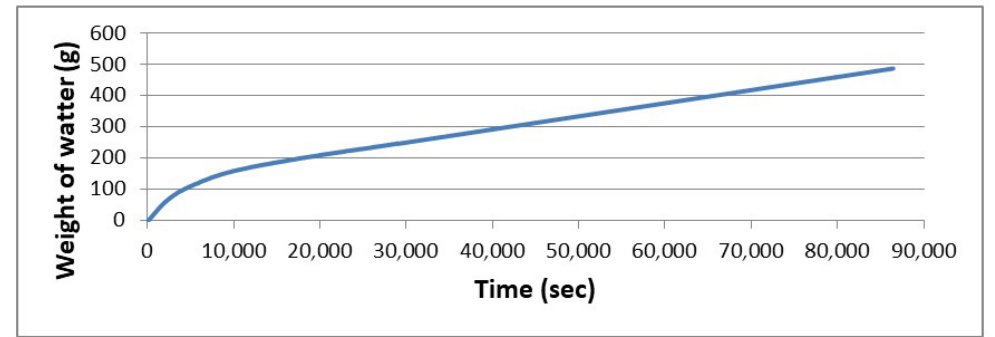
Figure 9. E ff ect of the nanofibrous membrane on the resistance of the sandwich panel against the long-term e ff ects of the water column.